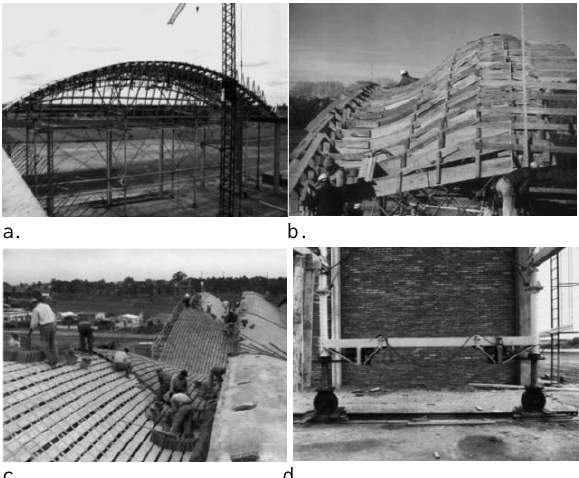
Figure 4: Synthesis of the construction primer of the Gaussian Vaults: a-b) building the longitudinal and transverse formwork from the calculated geometry, c) the bricklaying and introducing of steel reinforcement, d) gliding the formwork horizontally to the next structural